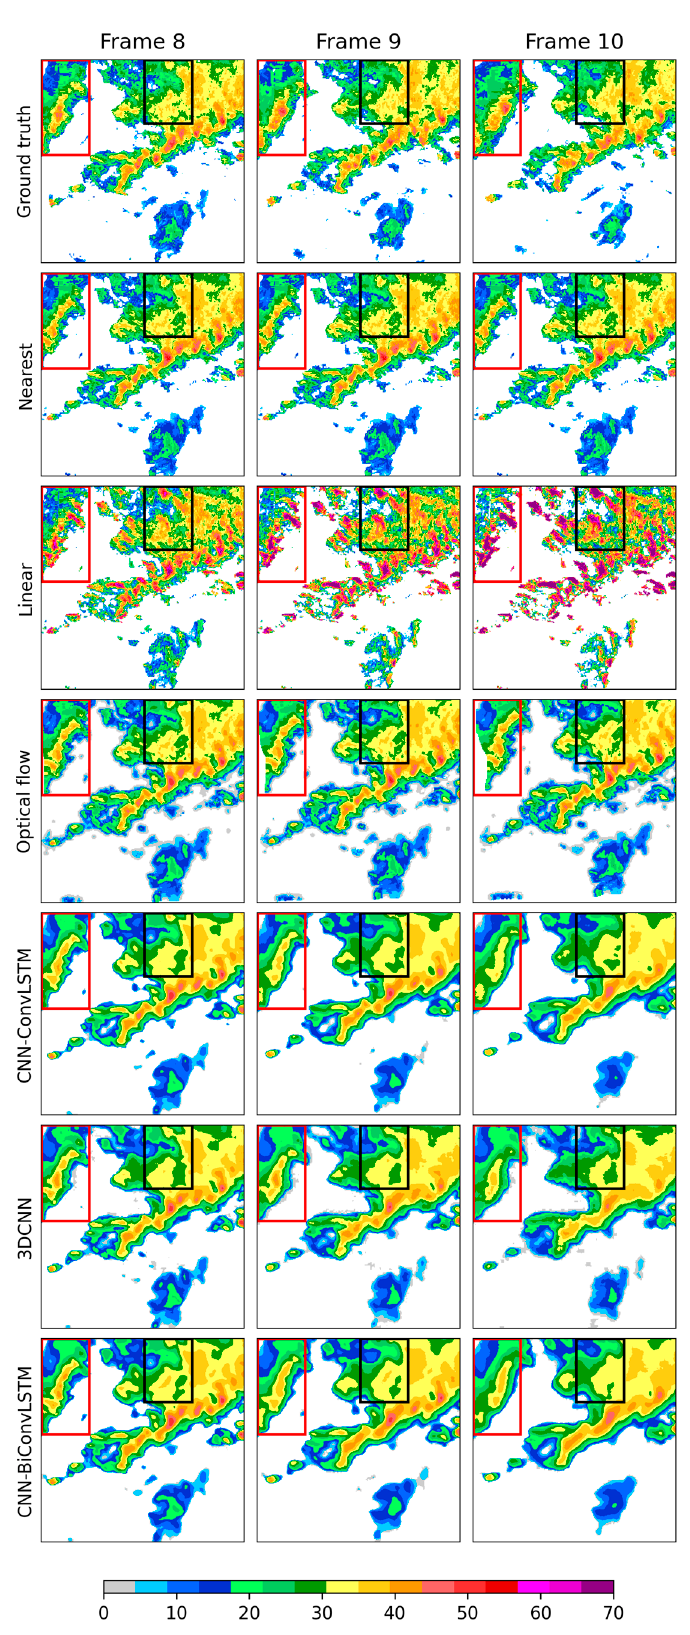
Figure 9. Comparison of different models in reconstructing missing radar frames for the missing pattern ‘1111111000’. The first line shows the 7th and 10th input radar images (ground truths); the 2nd line to the 7th line show reconstructed radar images from different models.